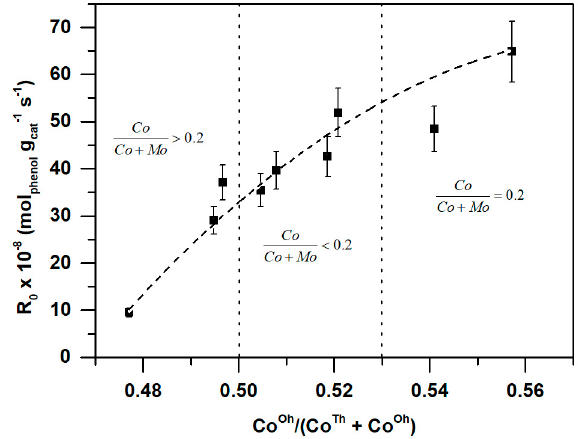
Figure 10. Correlation between the initial reaction rate of the HDO of phenol and octahedral Co of 10 wt.% and 15 wt.% Mo supported catalysts.